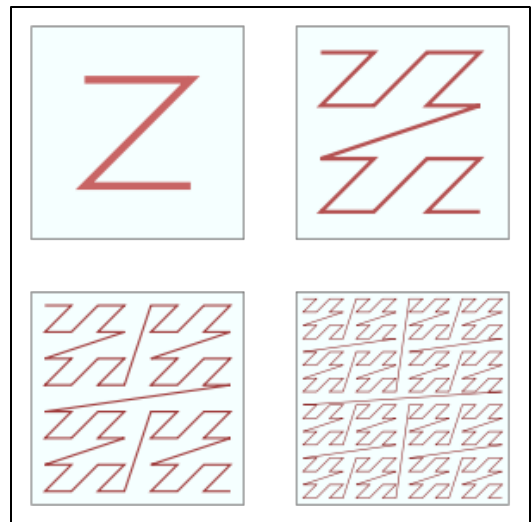
Figure 4. Four Iterations of Z-Order SFC